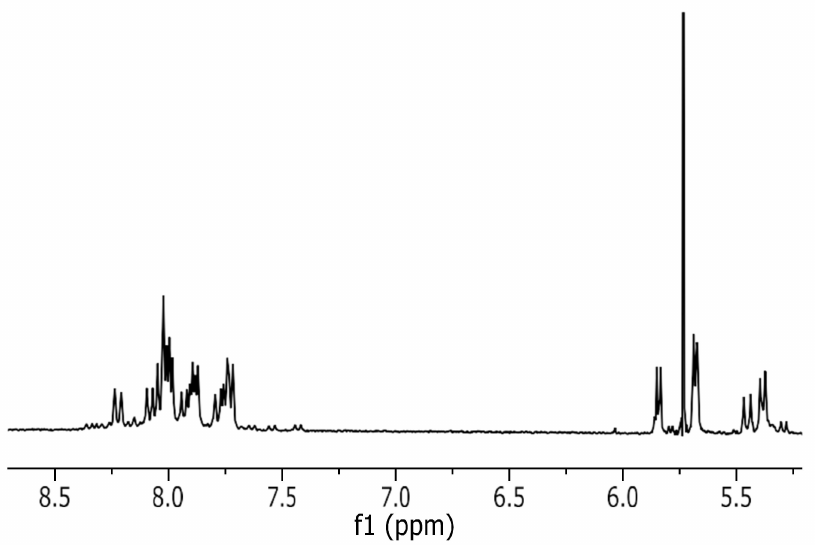
Figure 4. 1 H RMN Spectrum of 12 in DMSO-d 6 with the extended aromatic region in which the amide proton signals are present.